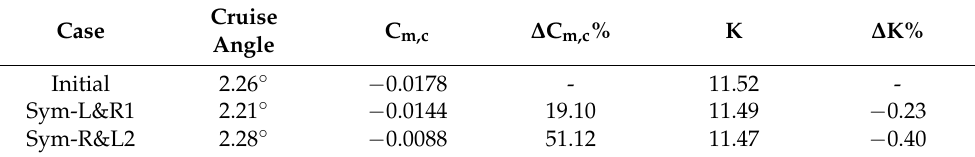
Figure 29. Aerodynamic characteristic of the configurations with different symmetrical plane airfoils. Ma = 0.85, H = 11 km, α = − 2 ◦ ∼ 8 ◦ , ∆ α = 2 ◦ . ( a ) Lift coefficient, lift to drag ratio; ( b ) pitching moment. Table 8. The pitching moment and lift-to-drag ratio of each configuration at